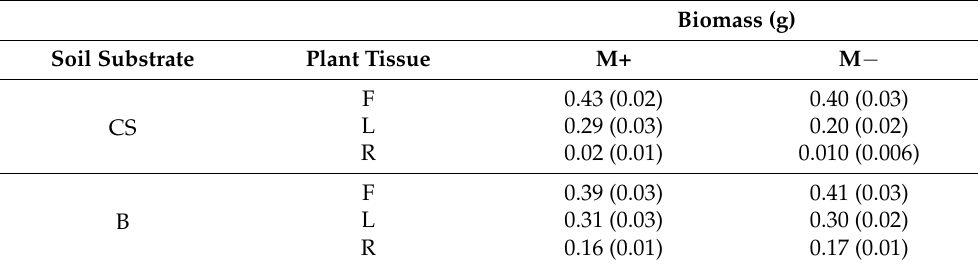
The Fisher test did not show significant differences between M+ and M − in B and CS treatments. Values are mean and standard deviation is reported in brackets (n = 4). F: Flower tissue; L: Leaf tissues; R: Root tissues.